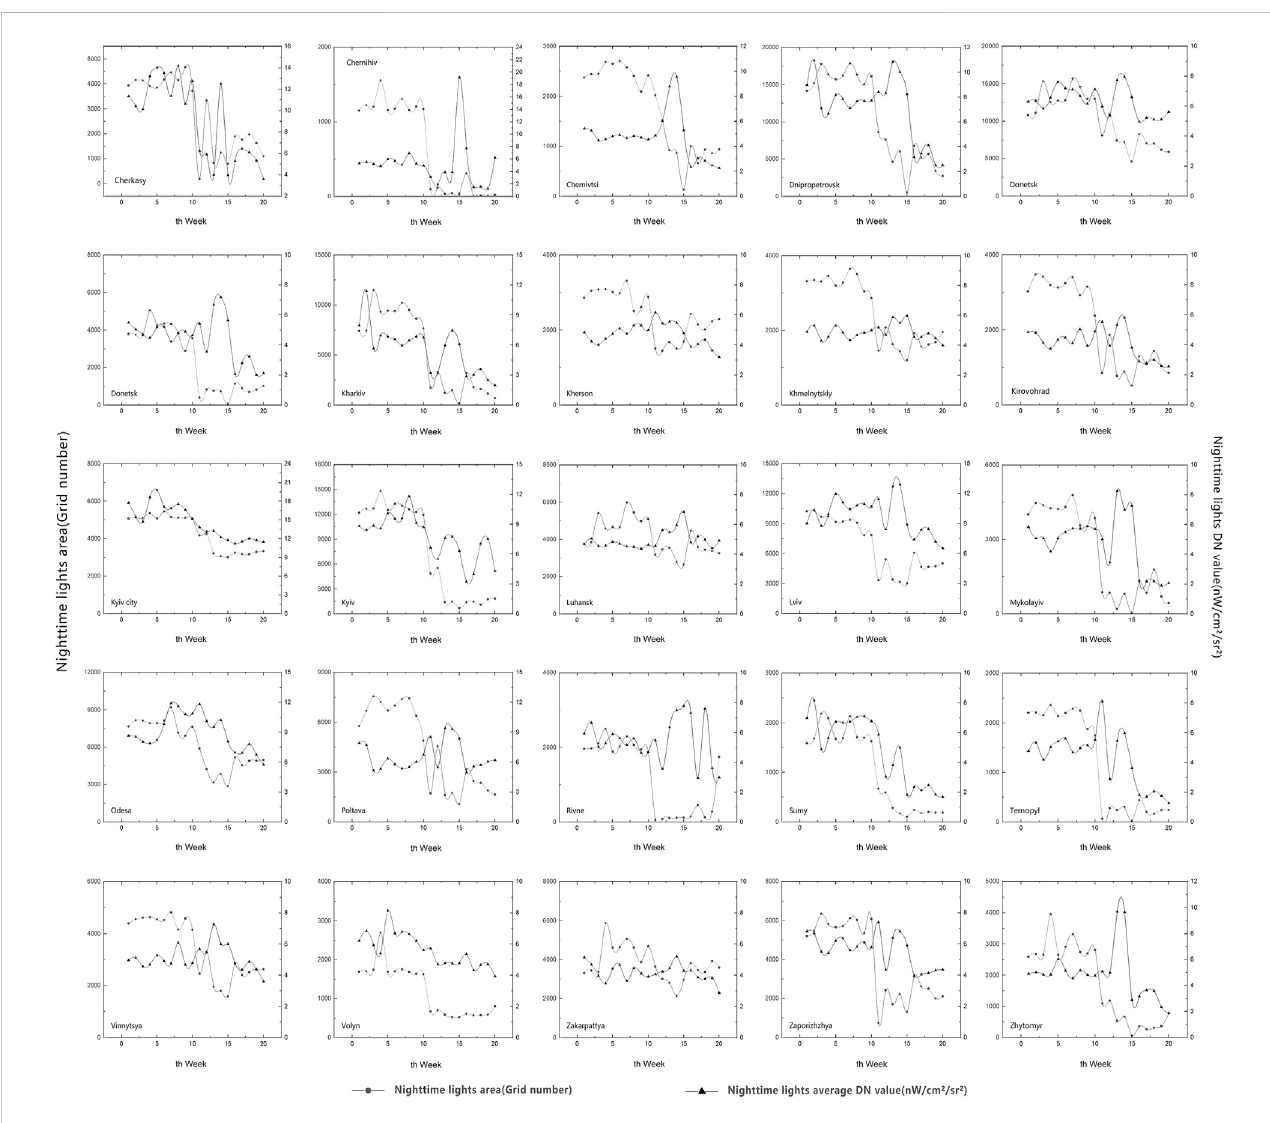
FIGURE 4 Weekly analysis of nighttime light trends in all oblasts of Ukraine (2021.12.16 –